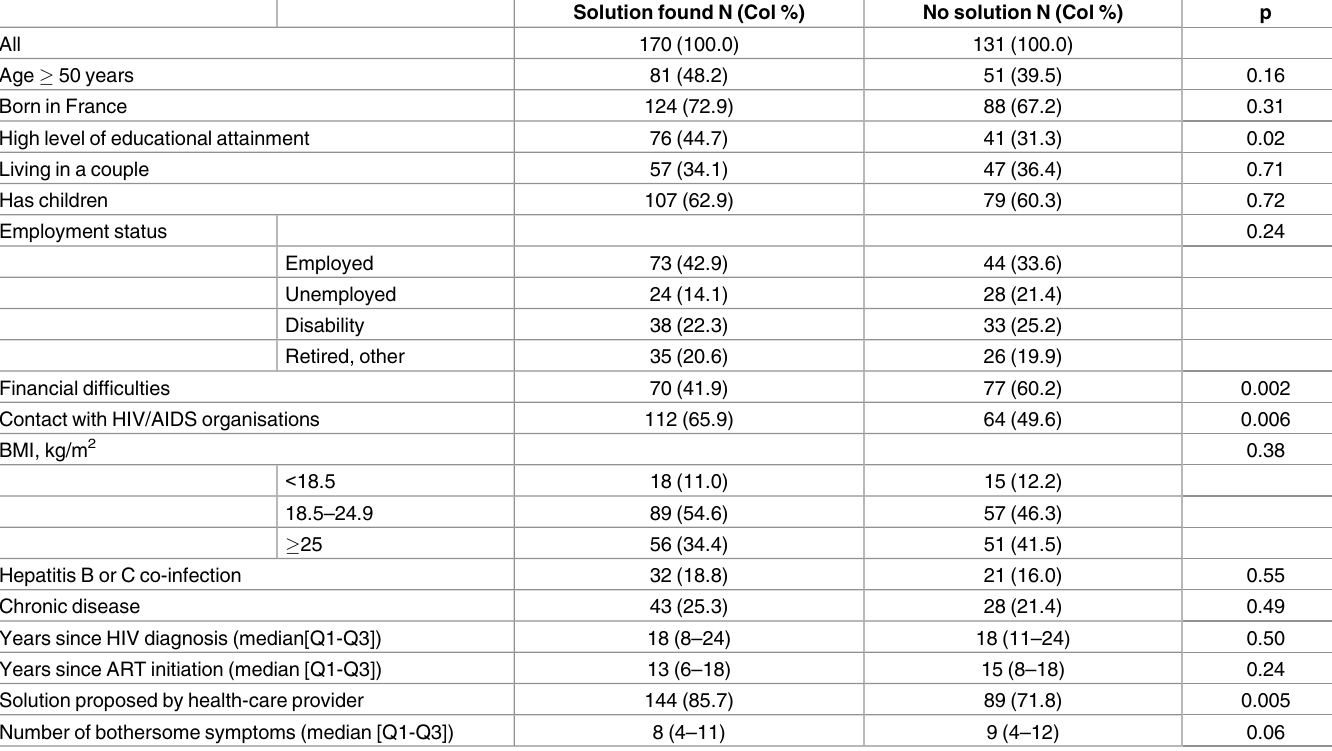
Table 2. Differencesin characteristics between women who reported having found a solution to relieving their side effectsand those who did not: the EVE study